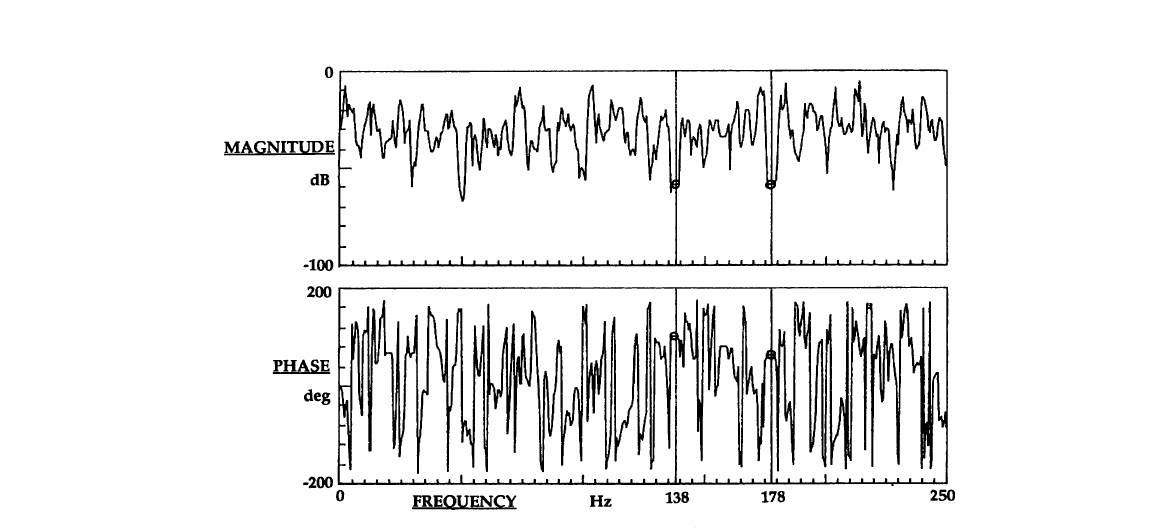
FIGURE 4 FRF spectrum (LDV signal/multiplier